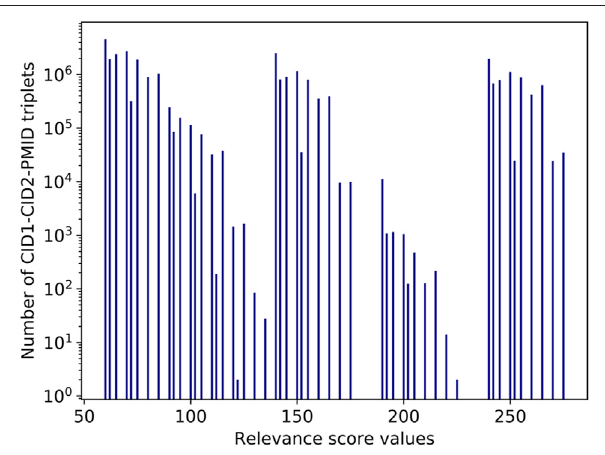
FIGURE 7 | Histogram of the relevance score